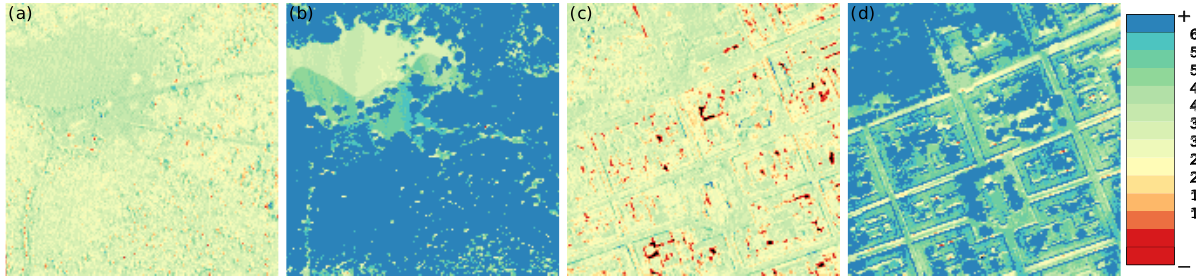
Figure 7. Color coded point density maps [points/m 2 ]; (a/b) forest: SPL/waveform LiDAR, (c/d) city: SPL/waveform